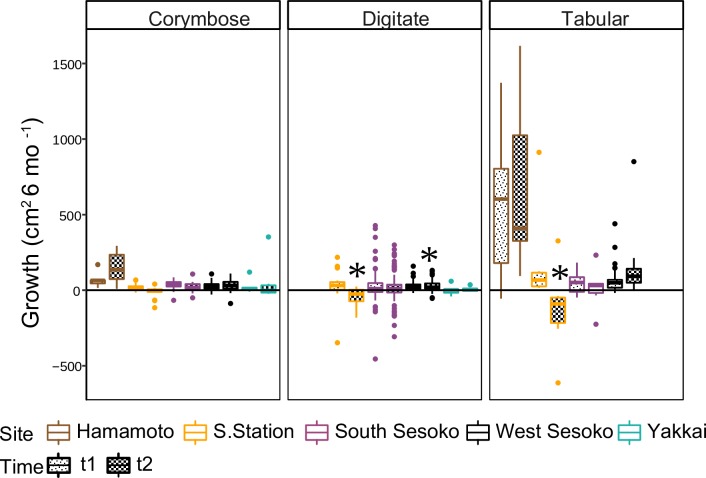
Spatio-temporal growth variation among Acropora morphologies at different study sites.Left and right bars of each pair represent growth in t1 and t2, respectively. Stars represent significant decrease of growth in t2.